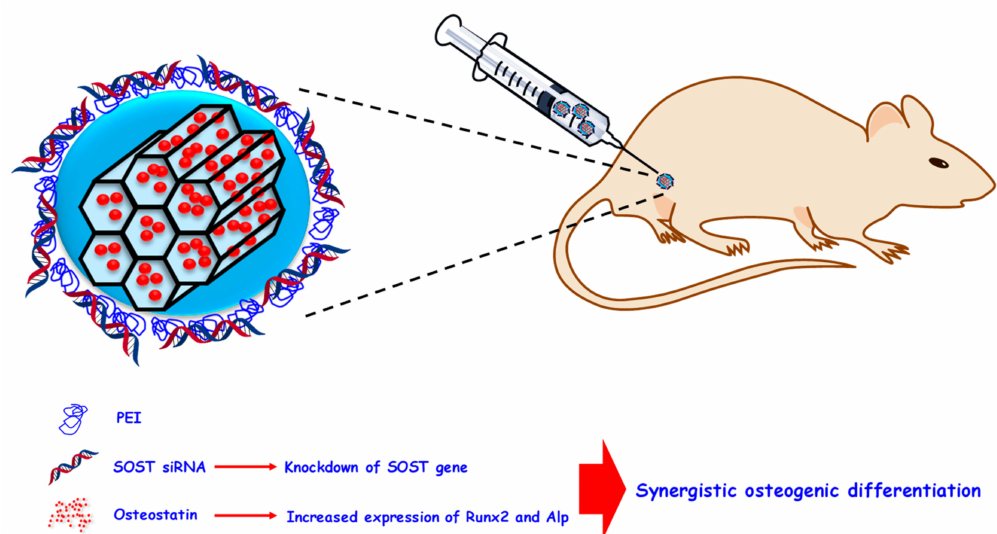
Figure 7. PEI-coated MSNs as anti-osteoporotic nanocarrier. Osteostatin was loaded in the mesopores and a siRNA able to knockdown the SOST gene was introduced within the polymeric mesh. The co-delivery of both therapeutic agents resulted in synergistic osteogenesis in ovariectomized mice. PEI: